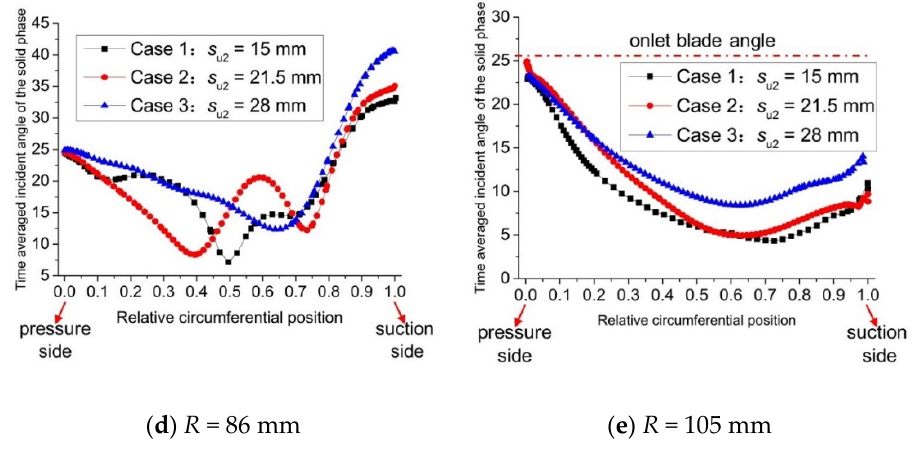
Figure 5. Time-averaged flow angles of solid particles in the three impellers.